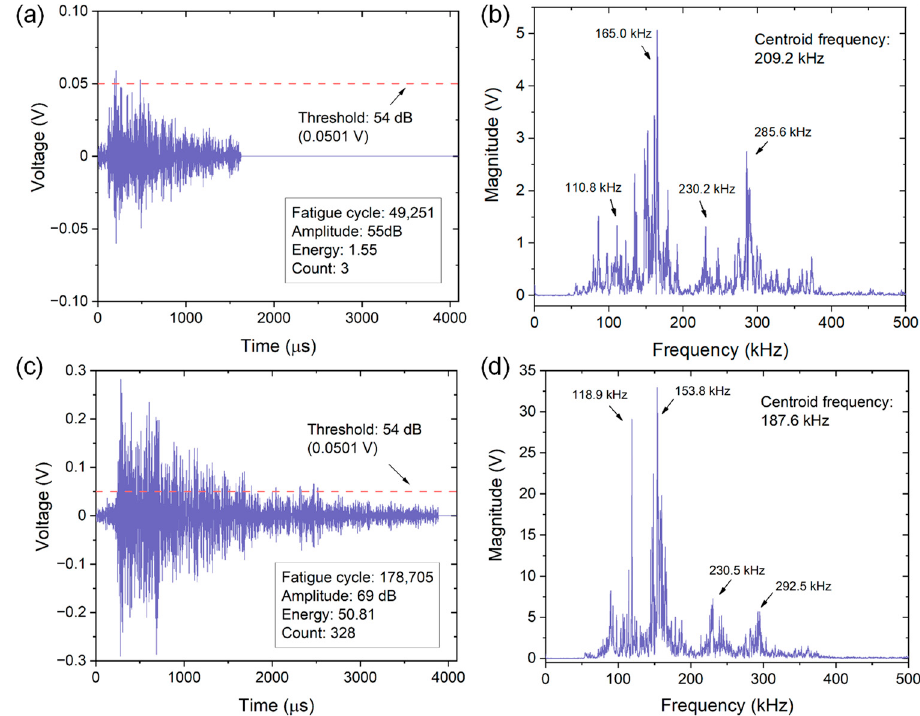
Figure 2. Time domain waveforms ( a , c ) and their corresponding FFT spectrums ( b , d ) of AE signals detected at the fatigue loading cycle of ( a , b ) 49,251 and ( c , d ) 178,705 of specimen No. 1. The threshold is also included in the time domain waveform for comparing the peak amplitude of two signals.